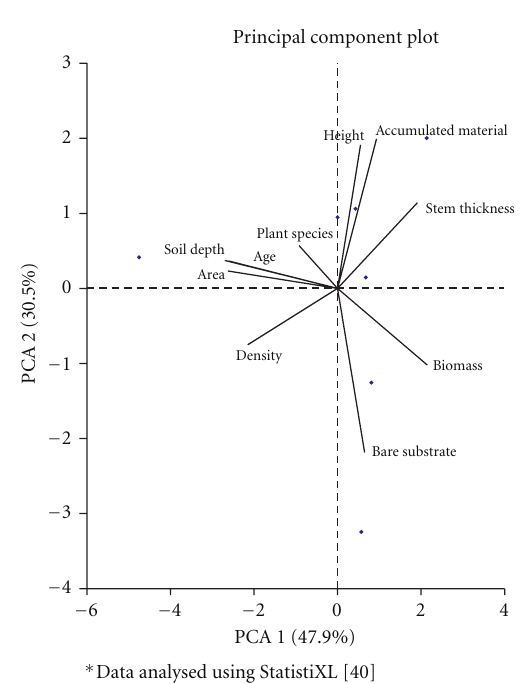
Figure 6: PCA ∗ of Biomass against all other Site-Specific Variables. From the PCA of Biomass of invertebrates across all reed-bed across all reed-bed sites, only bare substrate was found to be positively correlated, whilst age, area, soil depth, and plant species richness were found to be negatively correlated. All other variables measured did not a ff ect species